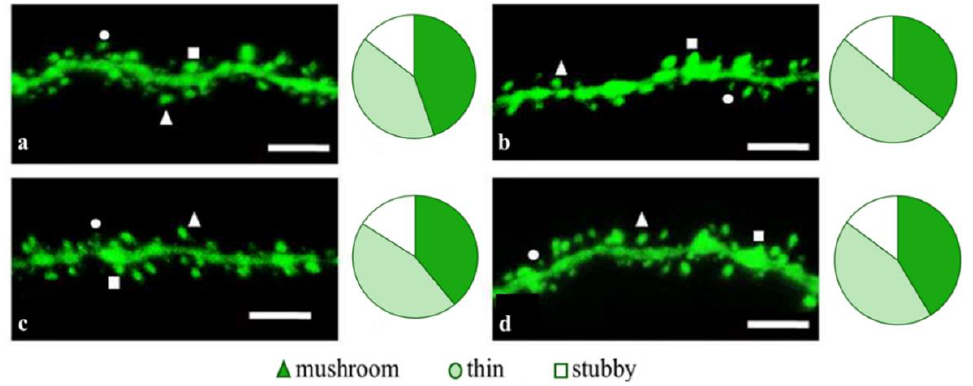
Figure 2. Confocal images of the CA1 secondary dendrites in 5 month-old M ( a ) and 5xFAD-M mice, injected with a physiological solution ( b ), EDR peptide ( c ), KED peptide ( d ). Confocal microscopy, ×100. Scale bar, 10 um.